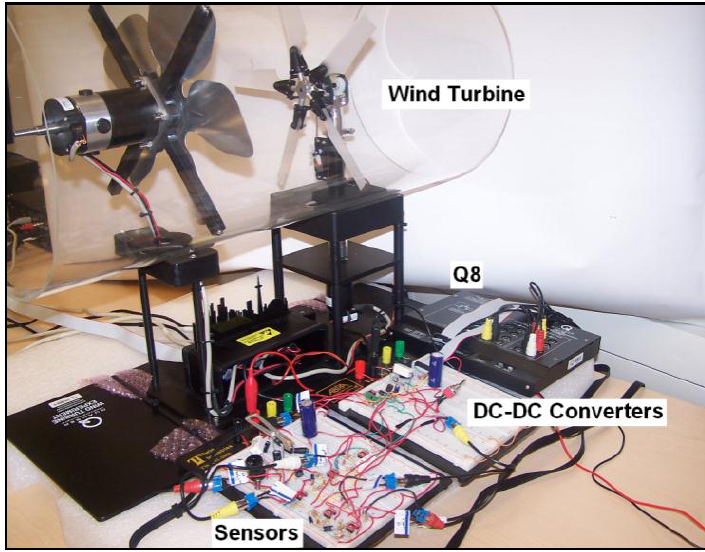
Figure 4. DC generator wind turbine experimental system.